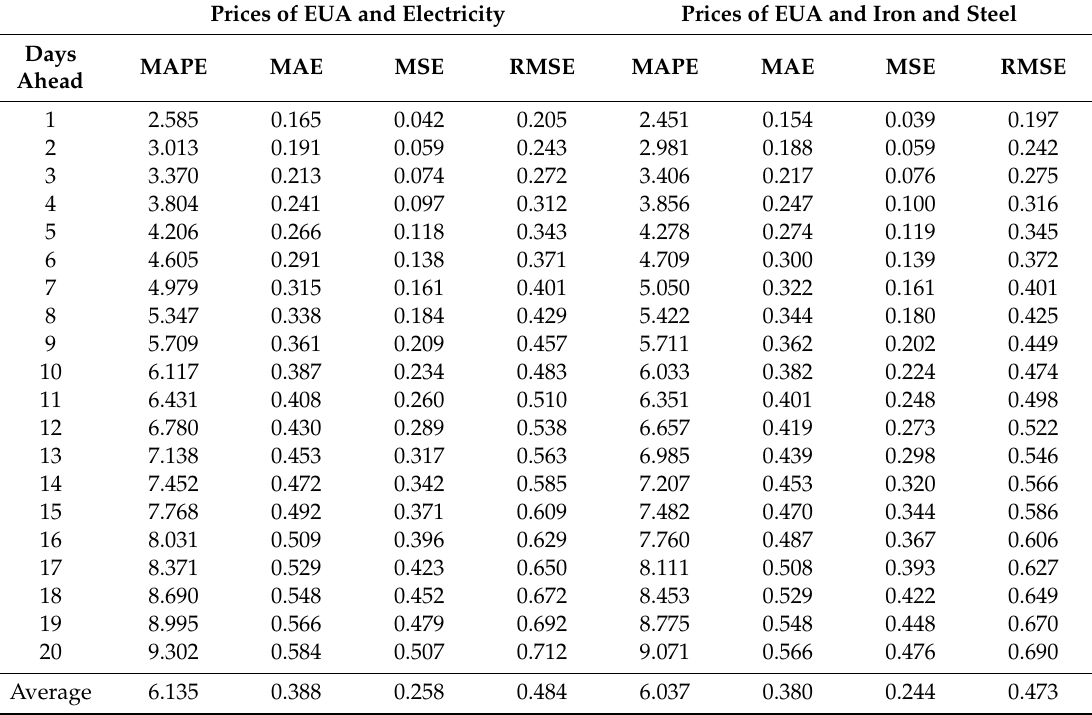
Table 5. Prediction errors of prices of CO 2 emission allowances when electricity prices and iron and steel prices are also separately used as input variable. Prices of EUA and Electricity Prices of EUA and Iron and